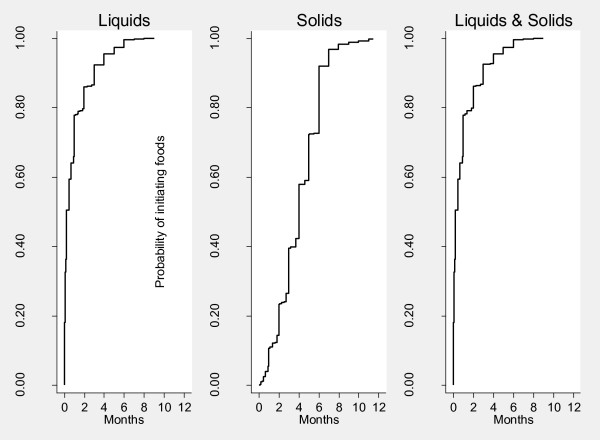
Probability of initiating complementary foods for specific ages, Nairobi informal settlements, Kenya.